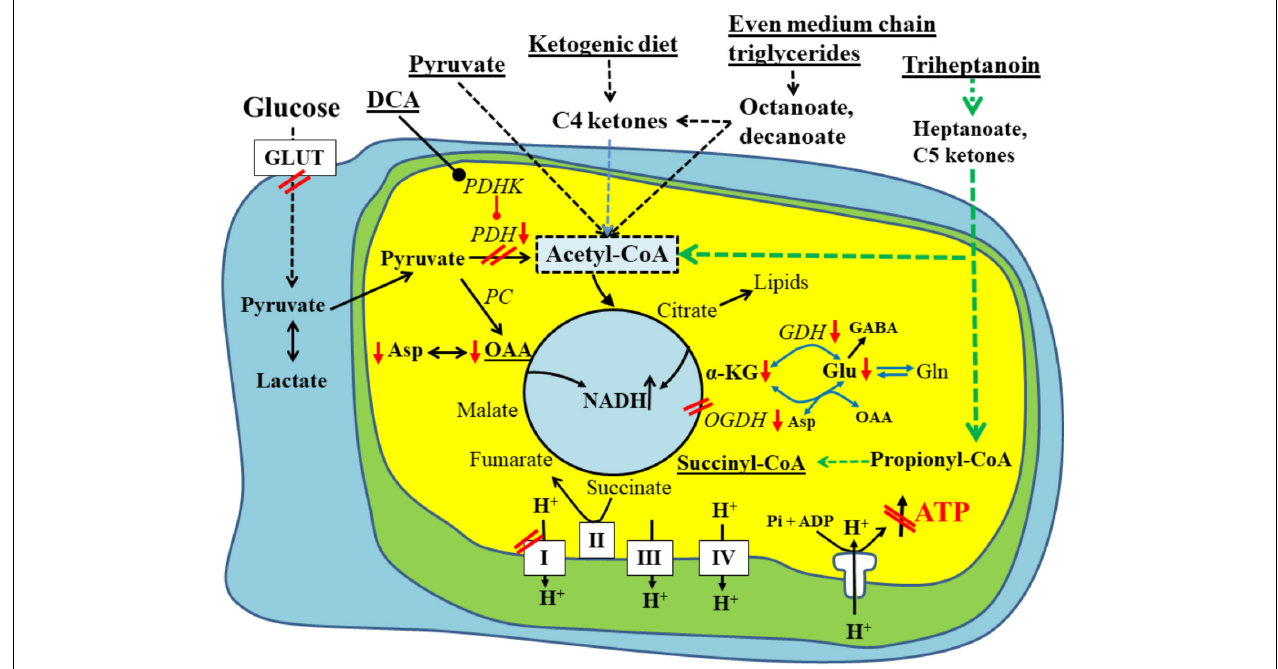
FIGURE 1 | Schematic of biochemical impairments found in chronic epileptic tissue and potential treatments thereof. A brain cell under normal physiological conditions uses glucose (left) as the main fuel and produces pyruvate by glycolysis. Pyruvate can be metabolized to lactate in the cytoplasm, if there is an imbalance between glycolysis and TCA cycle activity. Otherwise, pyruvate is taken up by the mitochondria (inner yellow/green area) and is further metabolized by pyruvate dehydrogenase (PDH) to acetyl-CoA, which condenses with oxaloacetate to form citrate, the first intermediate of the TCA cycle. The TCA cycle produces NADH, FADH 2 , which can be used by the electron transport chain (complexes1-IV on the bottom of diagram) and ATP synthase (complex V) to ultimately produce ATP. Please note that the TCA cycle intermediates are also precursors for lipids and amino acids. The red arrows and double lines indicate reductions in metabolite levels, activities of pathways, enzymes or complexes or glucose uptake, which have been described in epilepsy in either human brains or animal models (see text for explanations). These impairments all limit ATP production by ATP synthase depicted in the diagram as a crossed out arrow in front of ATP in the lower right corner. Several metabolic treatment approaches for epilepsy are underlined and shown on the top and their metabolic effects are indicated. This includes PDH kinase inhibition (such as dichloroacetate) to increase PDH activity as well as direct fuelling with pyruvate, C4 ketone bodies and medium chain fats, which all directly produce acetyl-CoA and do not require PDH for entry into the TCA cycle. Please also note that pyruvate and heptanoate are both providing C4 TCA cycle intermediates, namely oxaloacetate via pyruvate carboxylase (PC) or succinyl-CoA, respectively. This anaplerosis may contribute to TCA cycling as well